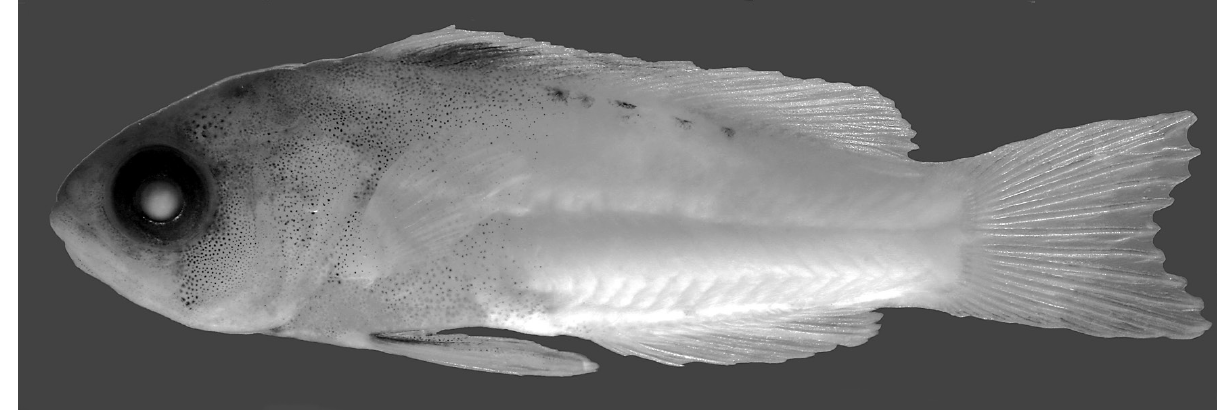
Fig . 2. – Transitional Gramma loreto (10.7 mm) captured by crest net at Turneffe Reef, Belize. Photo by B.C. Victor.